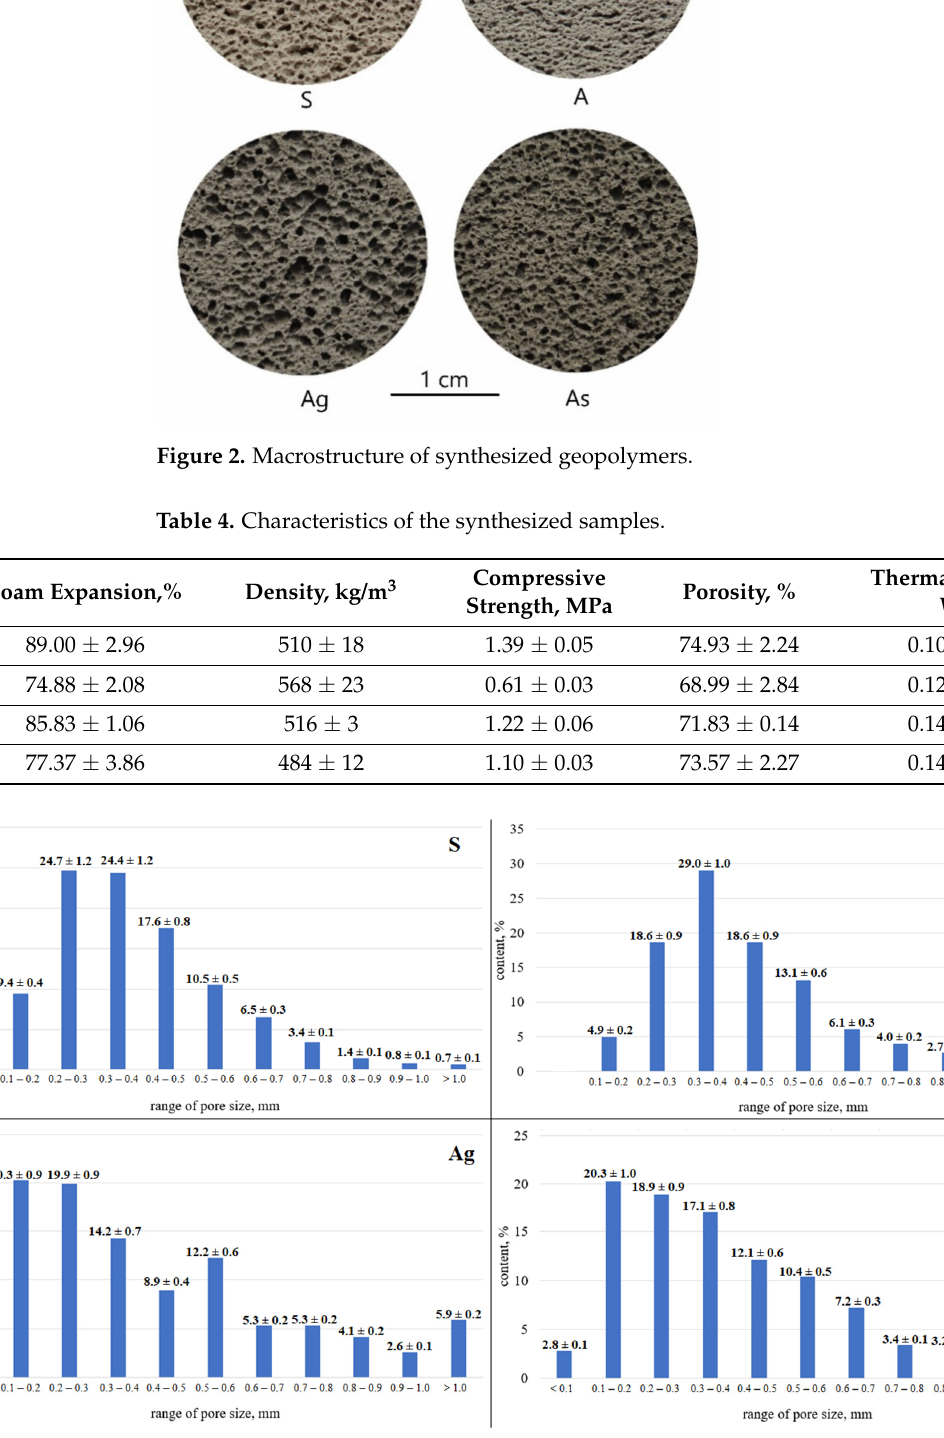
Figure 3. Histogram of Pore Size Distribution in Geopolymer Samples.